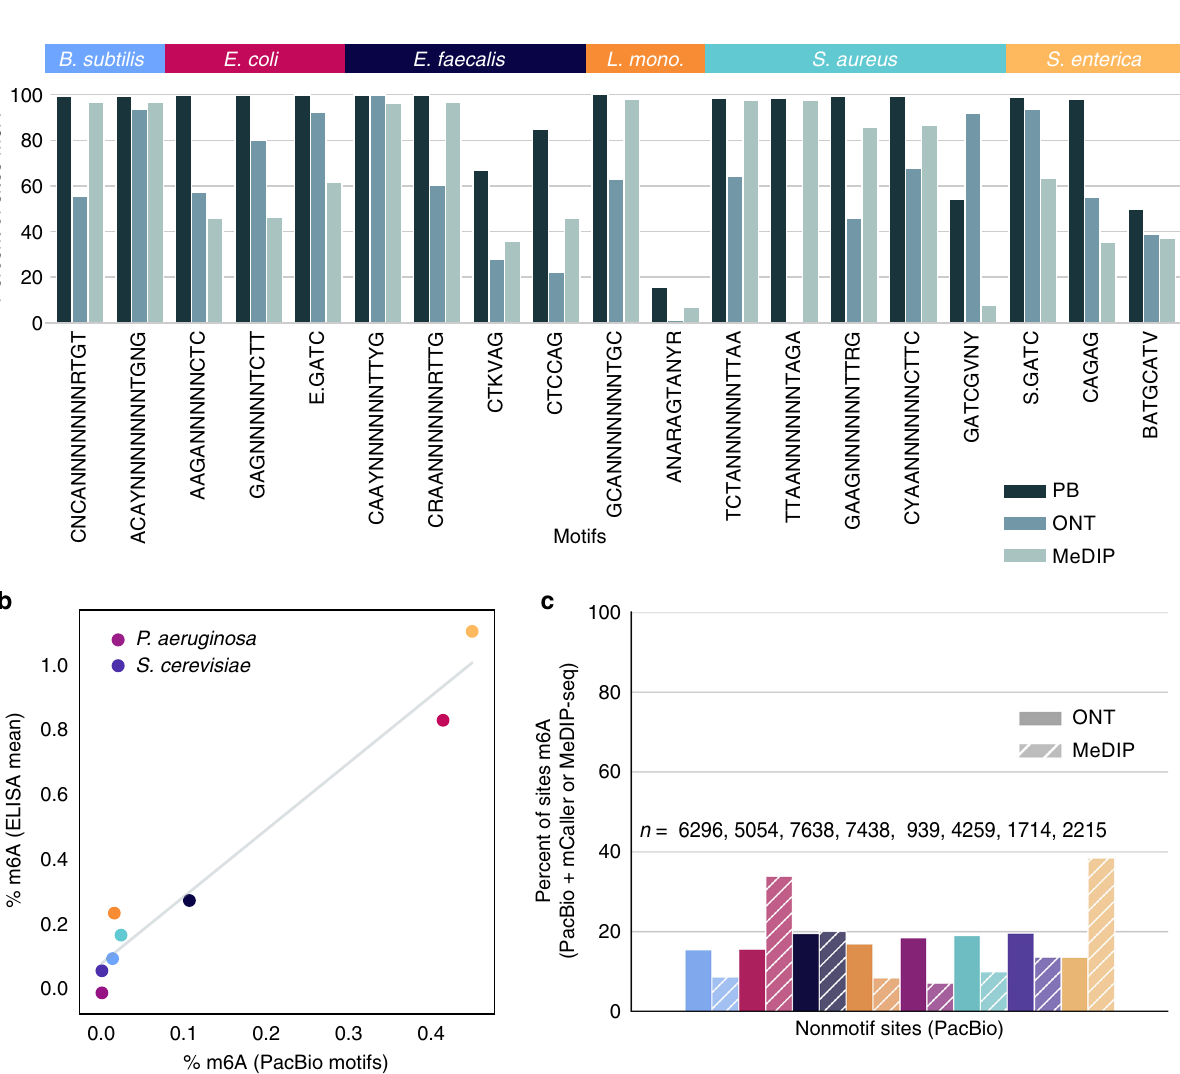
Fig. 3 Motif detection in a microbial reference community. a The percent of sites at different motifs identi fi ed as methylated by PacBio and nanopore (ONT) across species in a reference community. b A comparison between the percent m 6 A in the genome detected using a commercial ELISA kit and based on the motif sites identi fi ed using PacBio and con fi rmed by MeDIP-seq (Spearman ρ = 0.97, p = 6.54E − 6). c The percent of non-motif sites identi fi ed by PacBio that were also called called as methylated using mCaller. The total non-motif sites called by PacBio for each strain is noted as